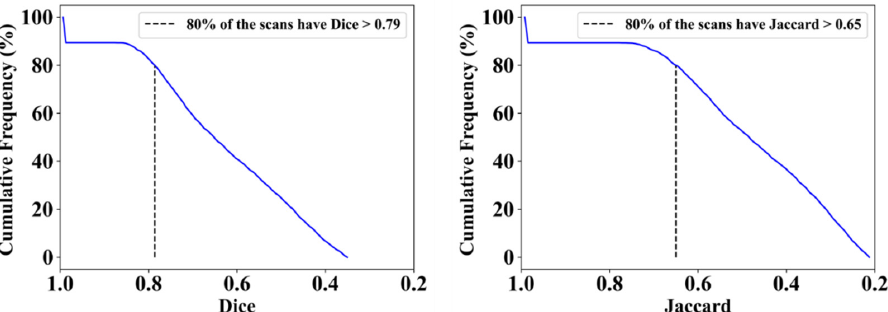
Figure 12. Cumulative frequency plots for Dice ( left ) and Jaccard ( right ) for PSPNet when computed against MD 1.